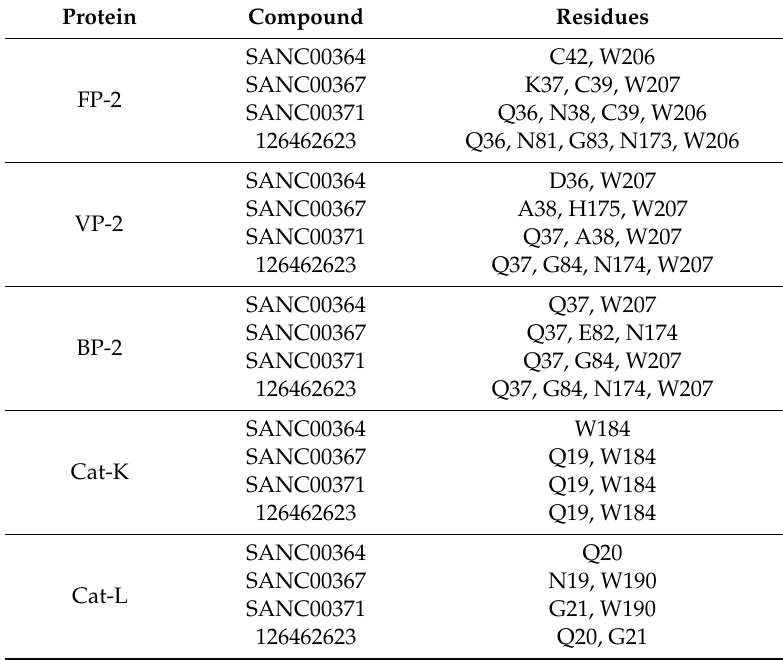
Table 2. Main hydrogen-forming residues during molecular dynamics in di ff erent proteins. Residue numbering is based on the catalytic domain (Table